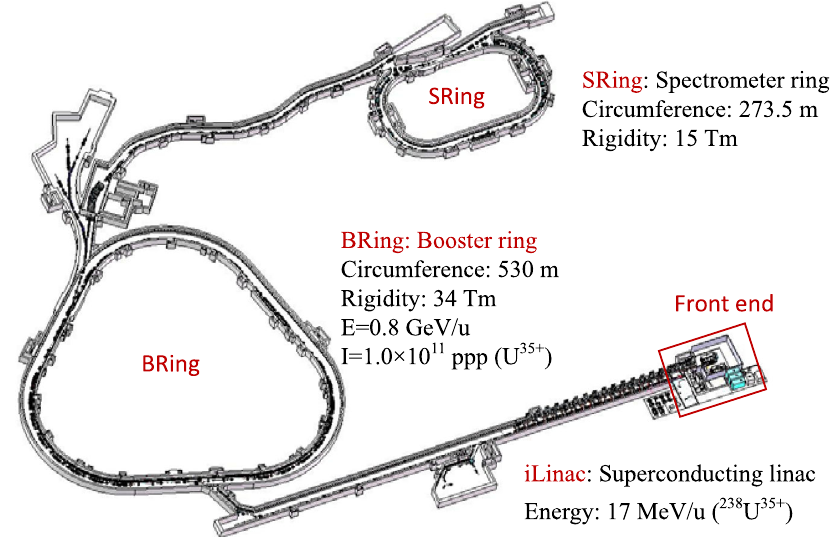
1. An overview of the HIAF